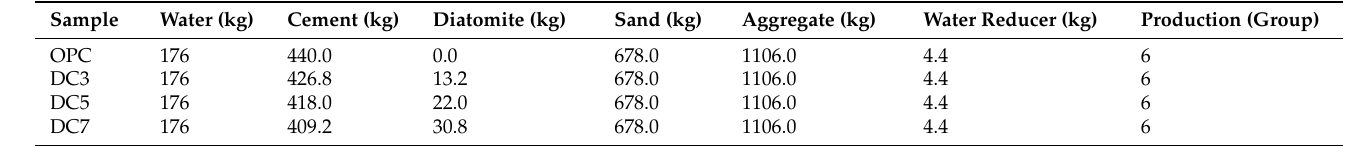
Table 3. Mix proportion design (1 m 3